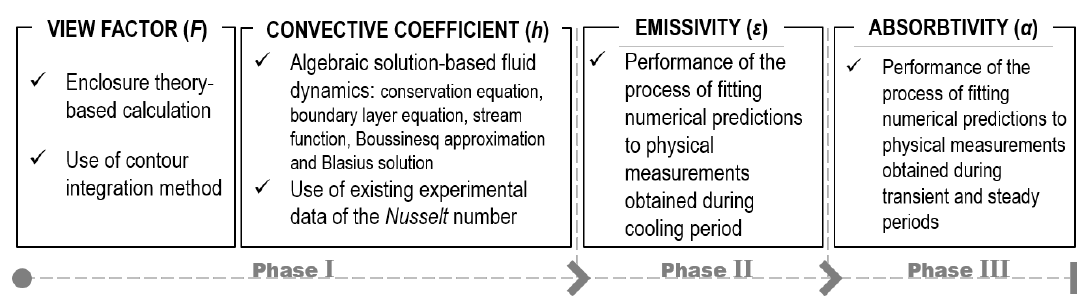
Figure 5. Determination procedure of controlling parameters representing thermal boundaries.